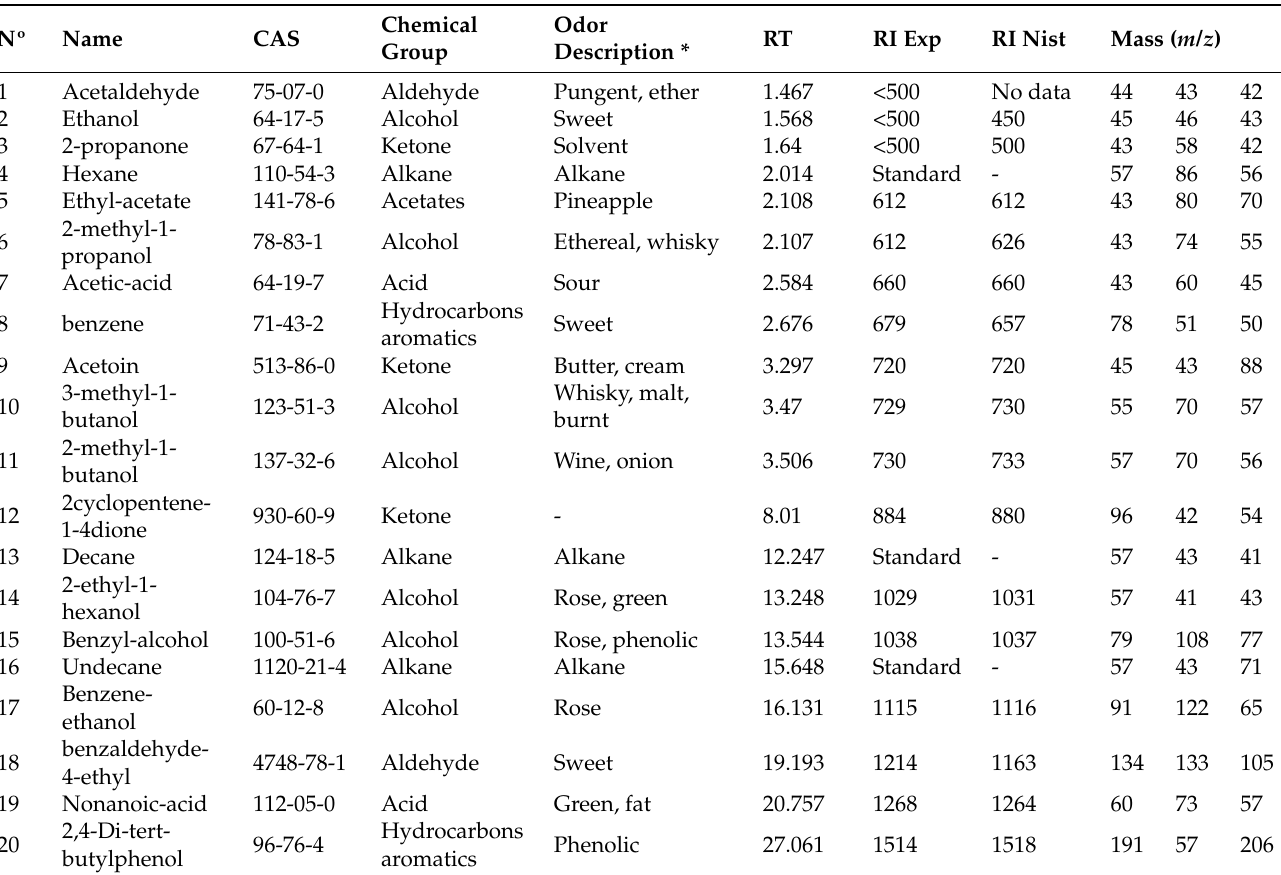
Table 1. List of volatile organic compounds identified by SPME-GC–MS in ST kombuchas fermented using SCOBYs 1, 2, and 3 (SC1, SC2, SC3).